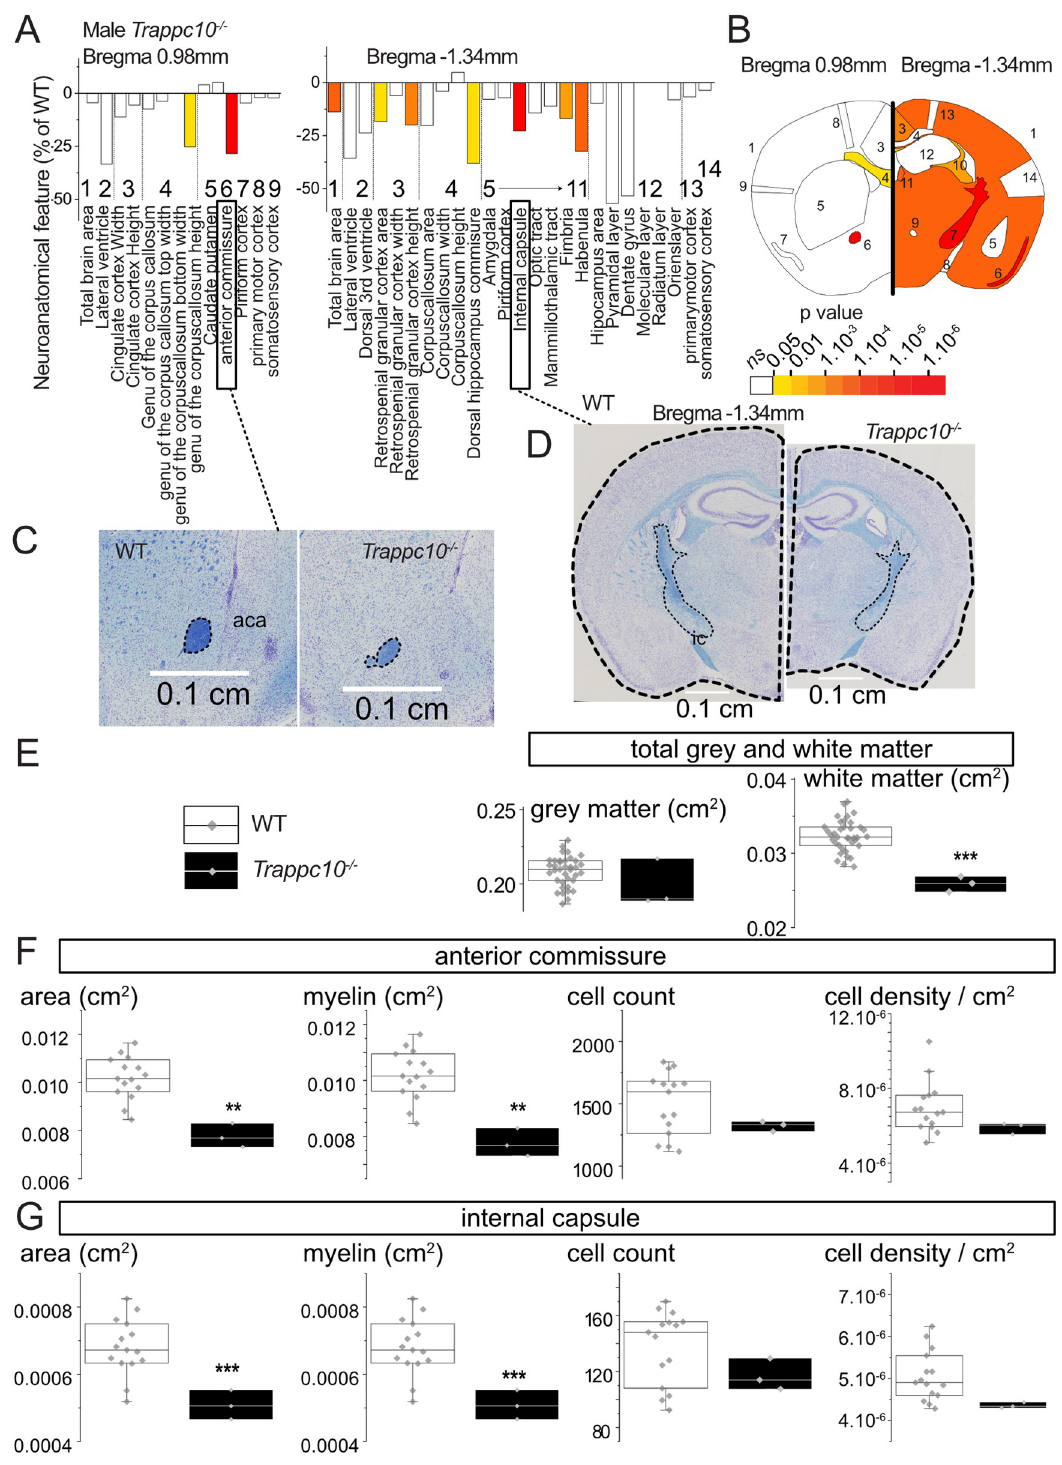
Fig 4. Mouse studies implicate TRAPPC10 in the formation of white matter structures. ( A ) Histograms for three homozygous Trappc10 -/- mice showing variation (decreased-minus scale or increased-positive scale) in areas and lengths expressed as percentage of 498 WTs together with a color map indicating the significance level (white indicates not significant). The list of measurements and corresponding numbers are shown below the histograms. ( B ) Schematic representation of a section at Bregma +0.98 mm and Bregma -1.34 mm. Colored regions indicate the presence of at least one significant parameter within the brain region at the